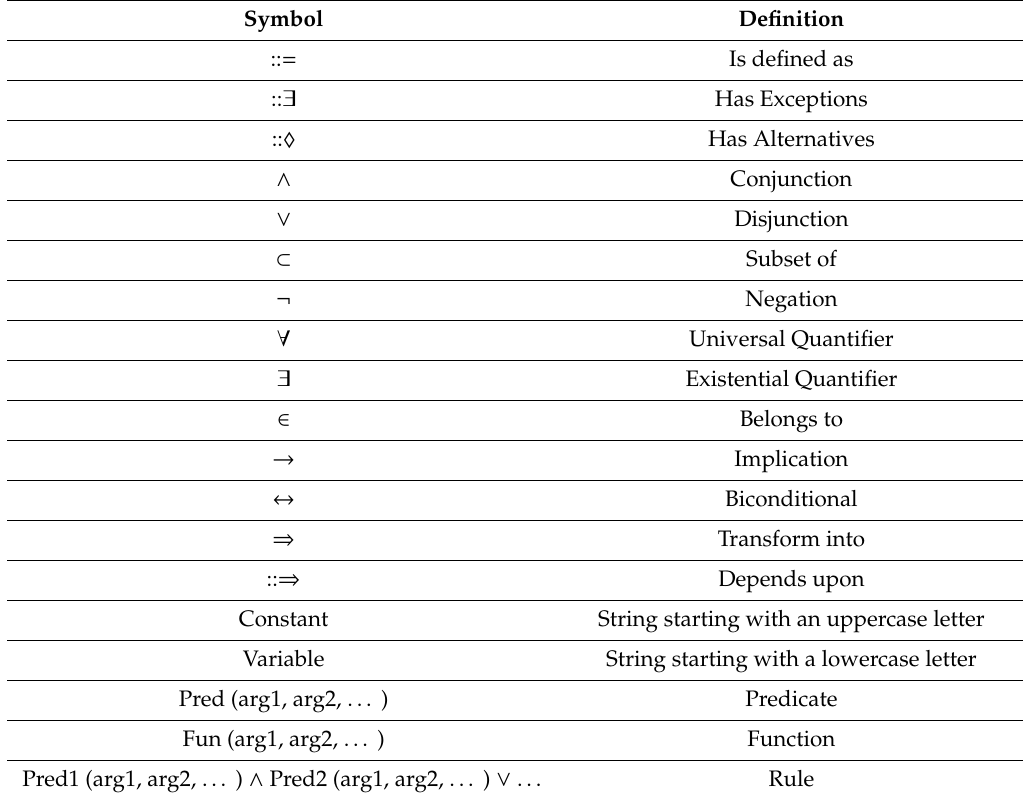
Table 2. The syntax of the Transformation Reasoning Algorithm